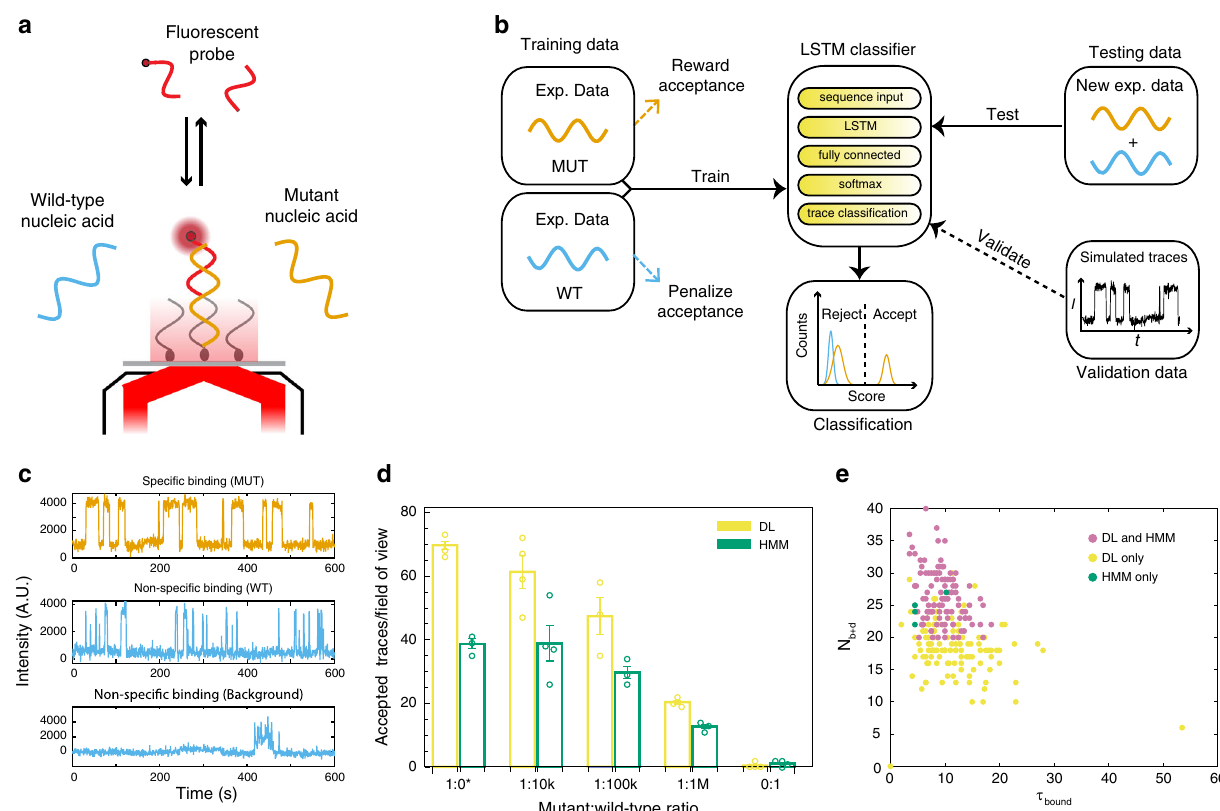
Fig. 2 Training and classi fi cation using the LSTM deep learning algorithm of AutoSiM for the analysis of one-color single-molecule traces with known ground truth. a Schematic of experimental system for detection of a mutant DNA sequence by SiMREPS. b Schematic of LSTM data processing. In the training phase, since the presence of even a few false positives (MUT detection events) in the WT dataset has a strong impact on speci fi city, the training loss function strongly penalizes the classi fi cation of traces from the WT dataset as MUT traces. In the validation phase, we used simulated traces to understand the network ’ s decision. Validation is optional for routine use. In the testing phase, we examined the accuracy of classi fi cation by the trained LSTM network on an independent dataset comprising mixtures of MUT and WT sequences at varying ratios. c Representative experimental SMFM traces showing repeated binding to mutant molecule, as well as a typical trace showing non-repetitive nonspeci fi c binding (including wild-type-like